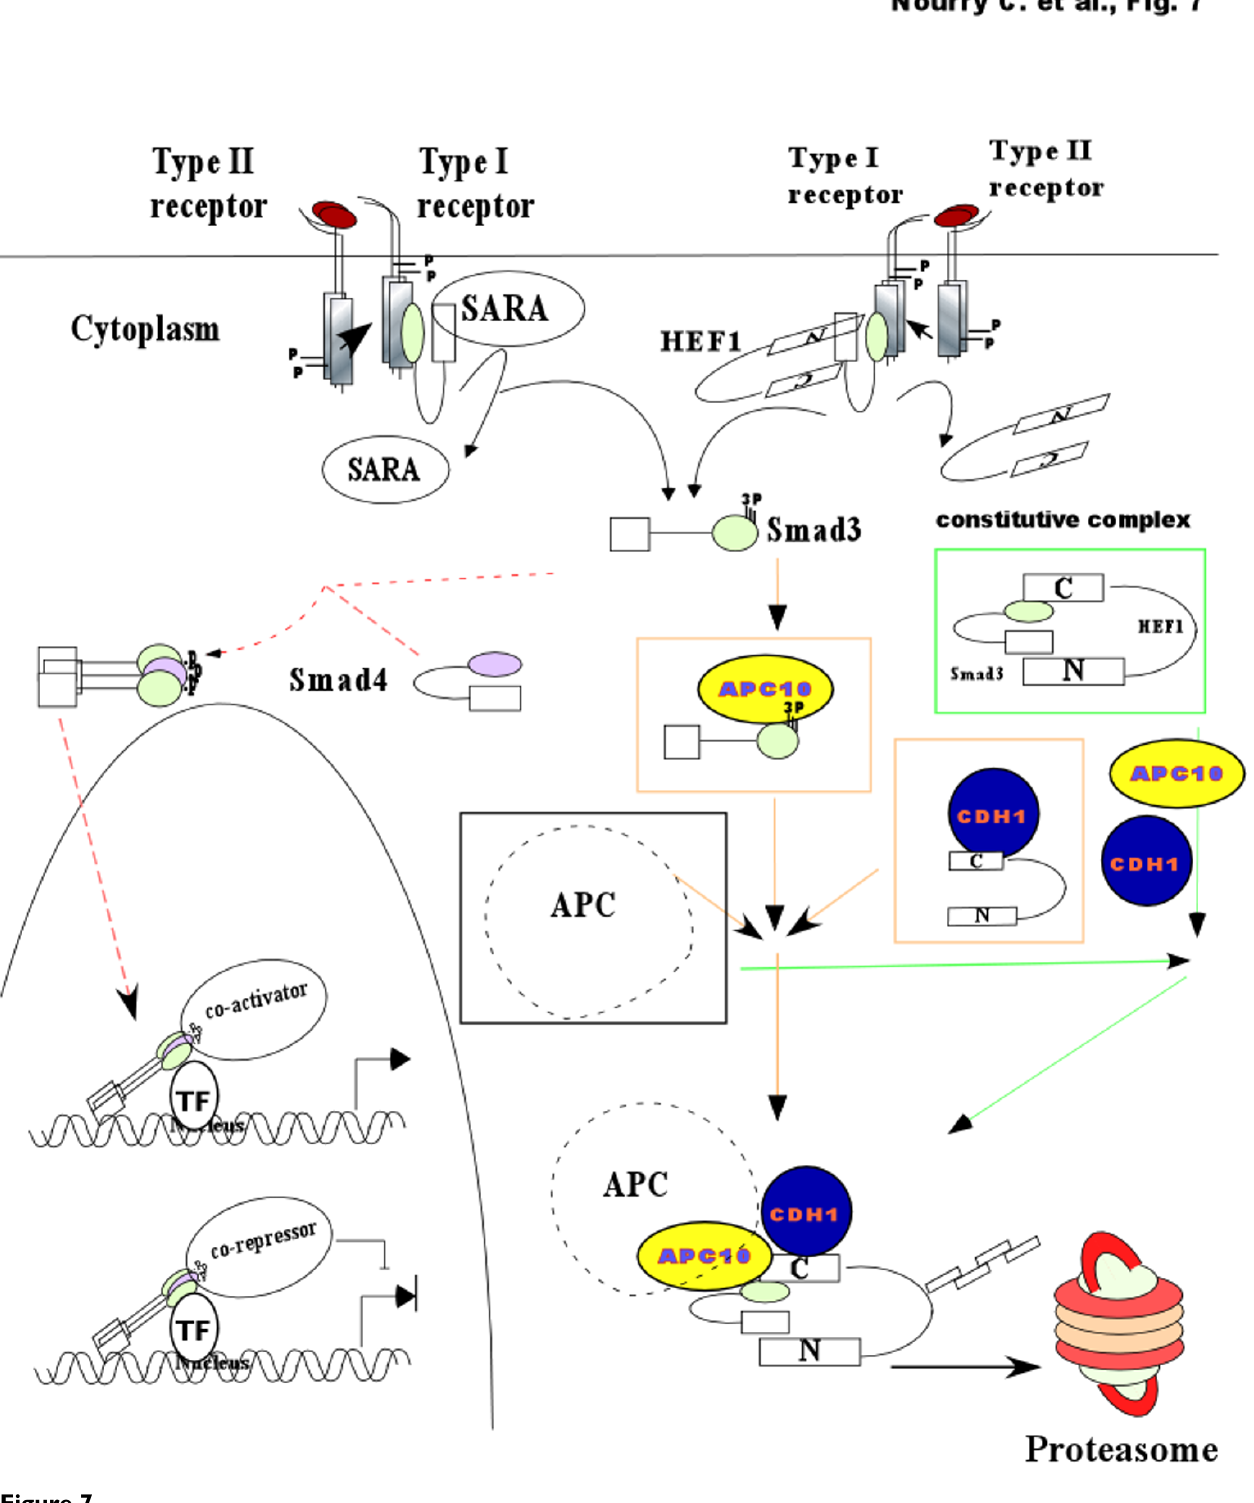
Figure 7 A cartoon for possible signaling pathways that involve Smad3 interaction with APC10. A cartoon that illustrates possible pathways for Smad3-induced HEF1 degradation involving APC10 and CDH1. Please see text for